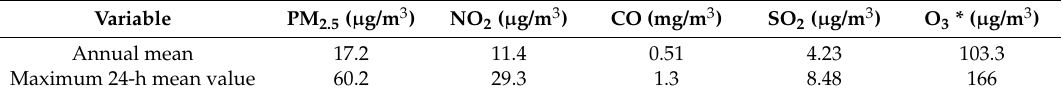
Table 6. Data on environmental pollutants detected by the monitoring station located in Galatina.